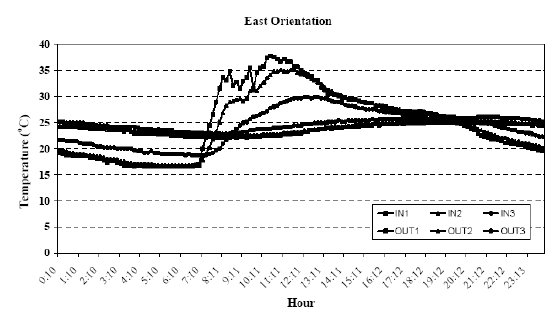
Figure 13. Temperature distribution inside and outside at east wall Summer period .